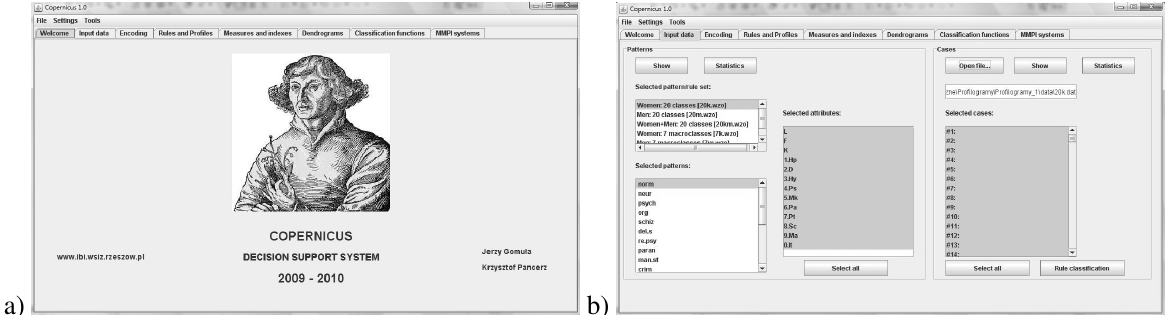
Figure 2: The Graphical User Interface of Copernicus: (a) welcome window, (b) input data